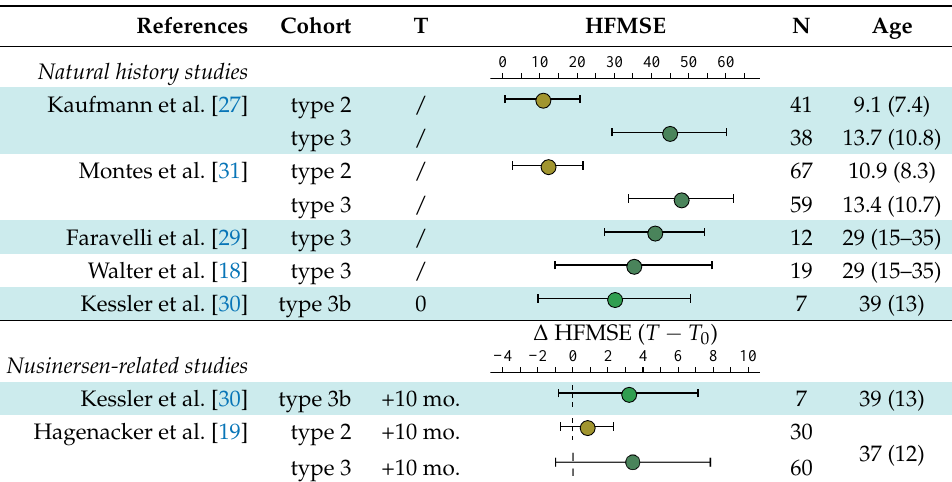
Table 2. Summary of representative Hammersmith Functional Motor Scale Expanded (HFMSE) scores by SMA subtype. Graphical representation of the HFMSE scores in SMA patients from five independent studies. Columns are named as follows. References : bibliographic citations of the natural history or Nusinersen-related studies. Cohort : cohort composition in SMA patients with specified type or subtype when the information is available. T : time when the analysis was performed; 0: baseline; +10 mo: 10 months after first Nusinersen dose. HMSFE : scores represented as a boxplot; values are indicated as median ± standard deviation (s.d.). ∆ HMFSE ( T − T 0 ) indicates the increment score between the baseline before treatment ( T 0 ) and the final after treatment timepoint ( T ). N : number of patients included. Age : age of the subject in years as reported in the relative study (median (s.d.)). Colors of boxplot and dots are related to the cohort characteristics (SMA type): mustard: SMA type 2; green: type 3; light green: subtype 3b. Background color associates consecutive table entries referring to the same